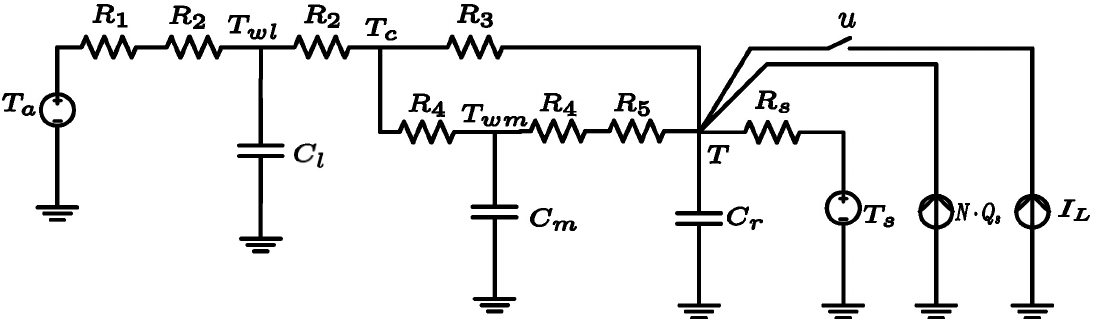
Figure 2. Proposed schematic circuit for a geodesic